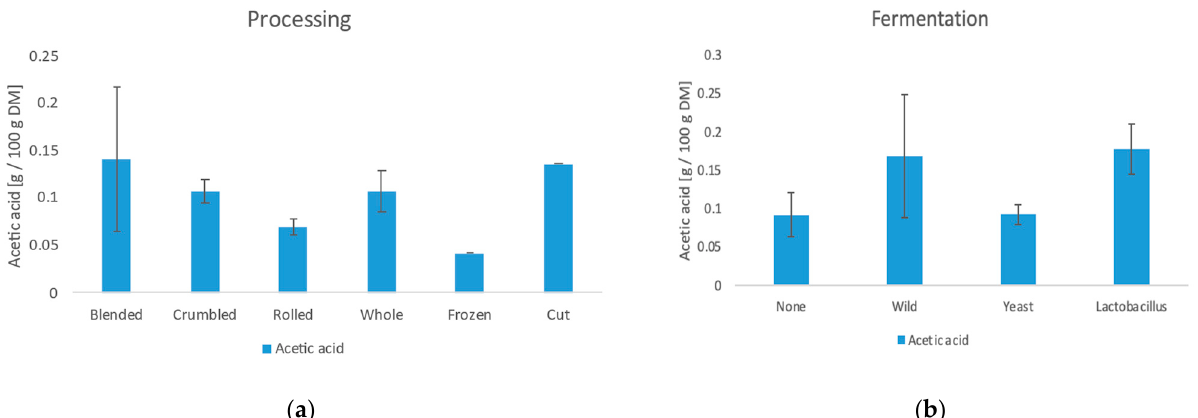
Figure 10. ( a ) Influence of the processing method on the acetic acid content. ( b ) Influence of the fermentation on the acetic acid content.